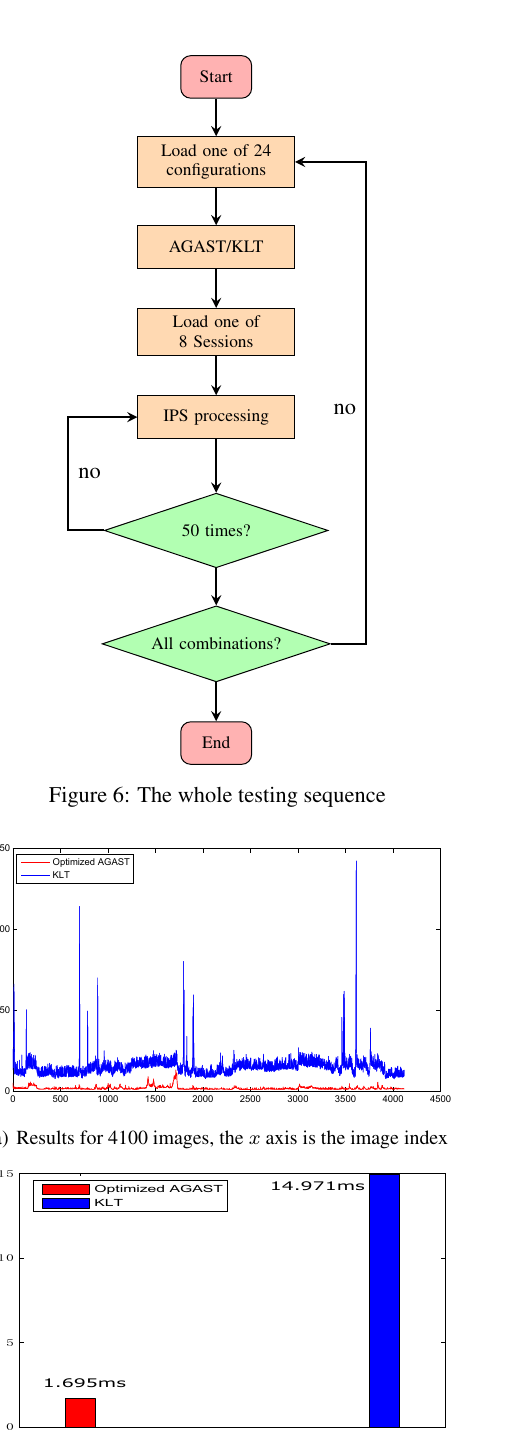
(b) Mean of 4100 testing results Figure 7: Processing times comparison